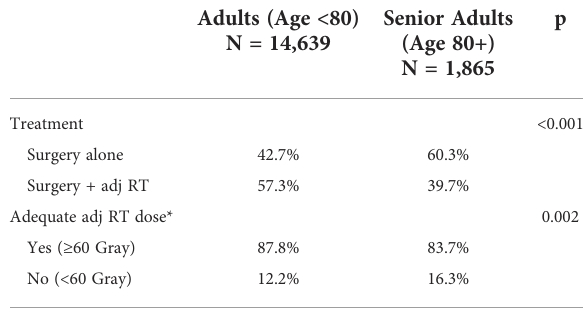
TABLE 2 Treatment types and radiation dose by age